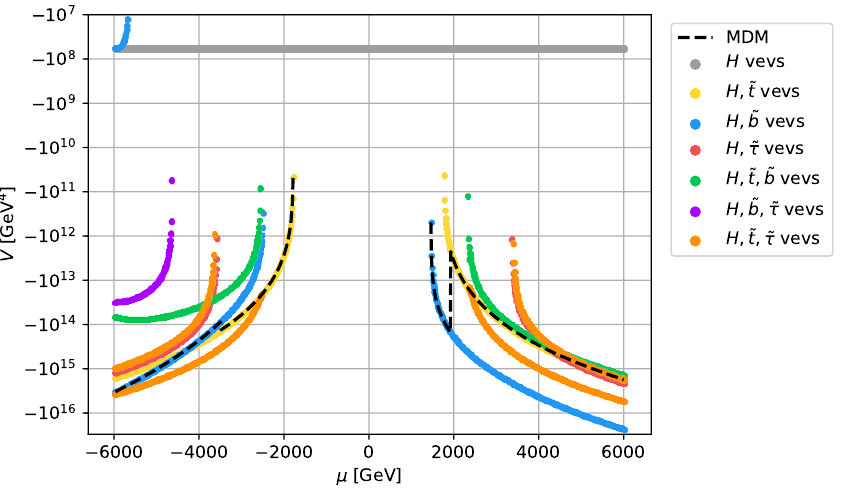
Figure 7 . Depth of the di(cid:11)erent types of stationary points along the line of constant X t = 2 : 8 TeV from (cid:12)gure 4. The colour code indicates which (cid:12)elds acquire vevs at the stationary point. The dashed line indicates which of the stationary points is the MDM. The grey line is the EW